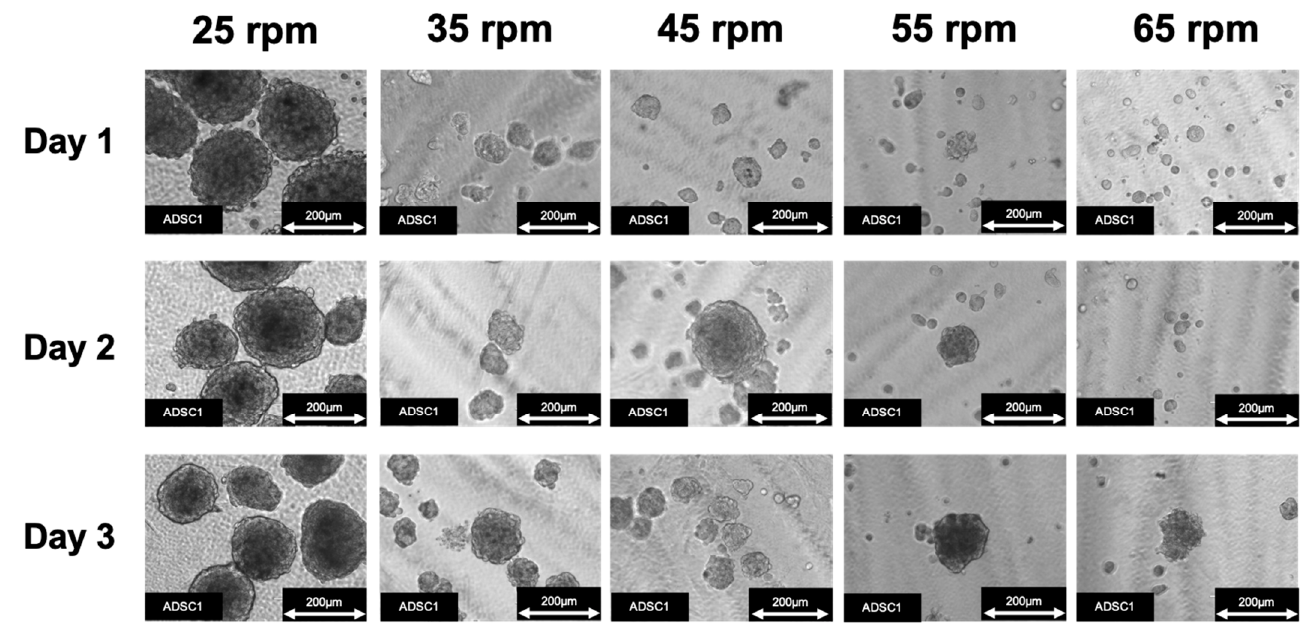
Figure 2. ADSC spheroid formation using SphereRing at different swirling speeds.